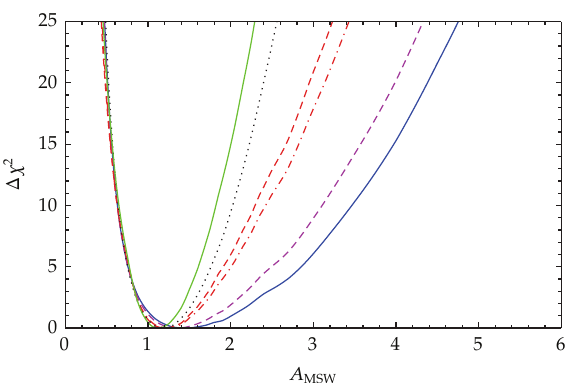
Figure 1: Δ χ 2 as a function of A MSW for the currently available solar neutrino data (cid:6) shown in blue solid line (cid:7) and the various solar neutrino observables expected in the near future (cid:6) by color lines specified in the following (cid:7) . The current data include the one from SNO lower energy threshold analysis and SK I–IV. In addition to the current constraints on A MSW , we show the improved constraints when future solar neutrino data are added one by one: 3 σ detection of the SK spectral upturn (cid:6) magenta dashed line (cid:7) , low-energy solar neutrino flux measurements of 7 Be at 5% and pep at 3% (cid:6) red dash-dotted line (cid:7) , and 3 σ detection of the SK day-night asymmetry (cid:6) black dotted line (cid:7) . The red dashed line shows the improved constraints by adding future spectral information at high and low energies. Finally, the global analysis by adding all the spectral information data and the day-night data produces the solid green